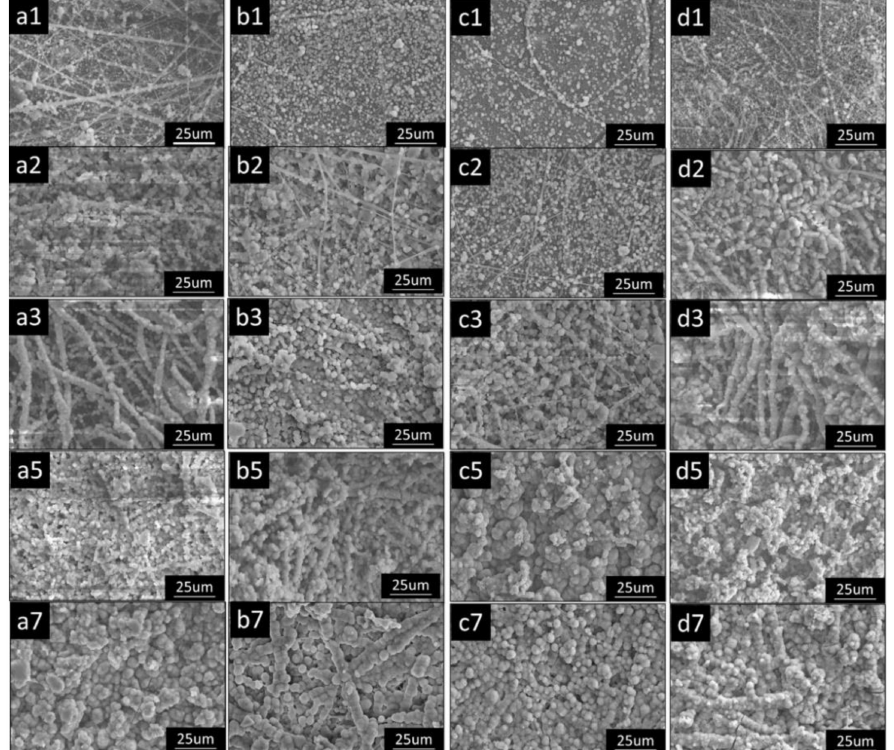
Figure 4. Scanning electron microscope images of the gradual deposition of minerals onto PLLA/gelatin composite nanofibers over time in different concentrated SBF (2.5 × ) fortified with amino acids (2.5 mM) at 37 ± 0.2 ◦ C. The numbers following the alphabets a–d indicate the soak- ing time (days). ( a1 – a3 , a5 , a7 ) 2.5 SBF-blank; ( b1 – b3 , b5 , b7 ) 2.5 SBF-Gly; ( c1 – c3 , c5 , c7 ) 2.5 SBF-Arg; ( d1 – d3 , d5 , d7 ) 2.5 SBF-Asp. The number shown in each panel of the figure represents the days